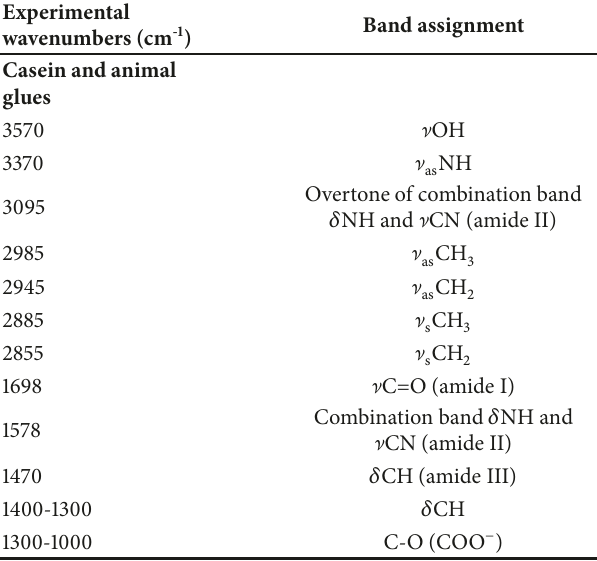
Table 1: Experimental wavenumber values corresponding to the maxima of the mid-IR total reflection mode bands of proteinaceous materials and their tentative